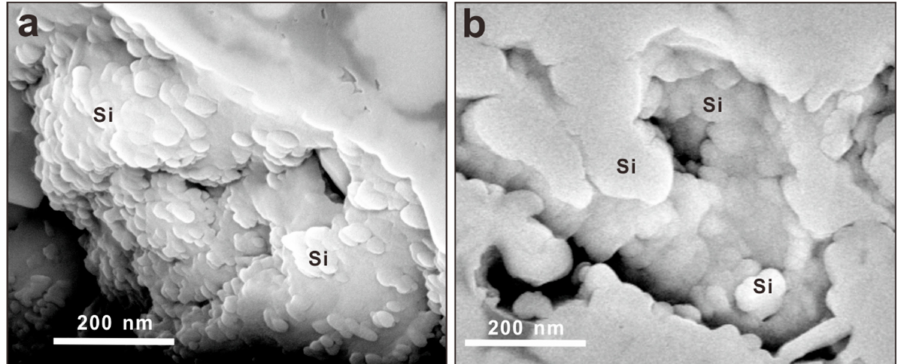
Figure 12. SEM images showing the development of abundant rounded silica nanograins. Silica nanograins have a minimum size of ~20 nm and a maximum size of ~100 nm. Black areas are the open interparticle pore space. ( a ) Features of the rounded silica nanograins within sample L1 and ( b ) features of the rounded silica nanograins within sample